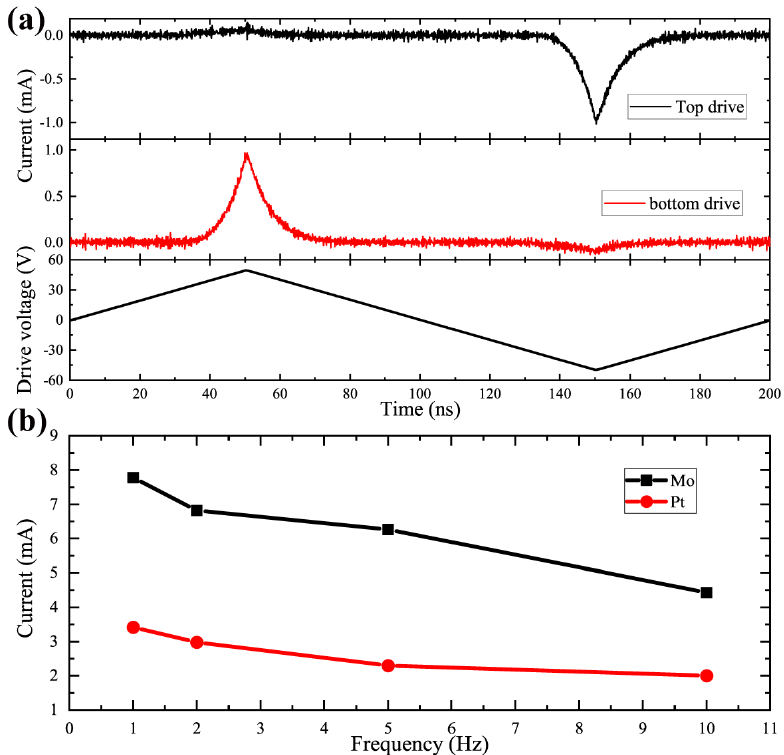
Figure 8. ( a ) Switching current with top and bottom drive under maximum 50 V triangle driving voltage. ( b ) The maximum voltage current as a function of driving frequency with the maximum voltage set to 60